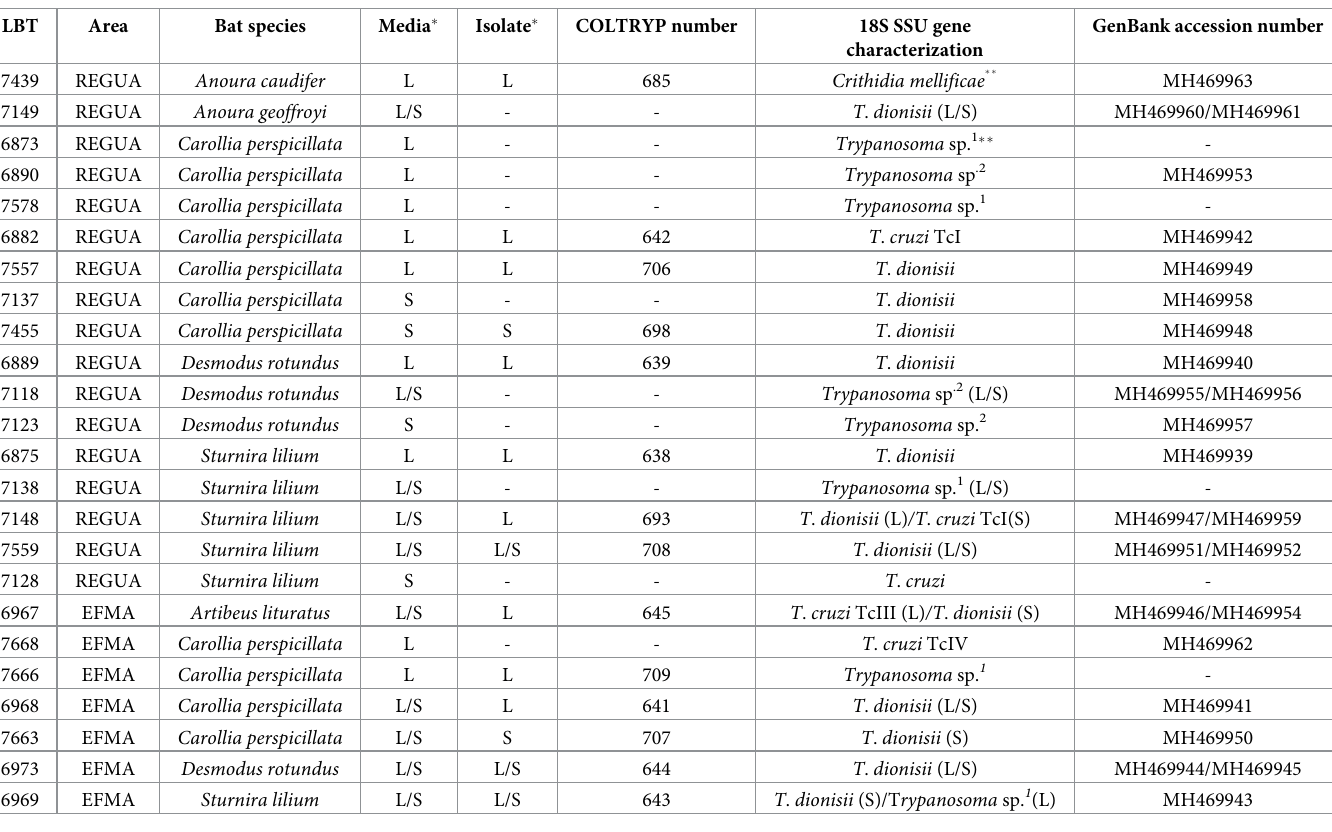
Table 2. Trypanosomatid species infecting bats. This table shows the bat identification number, area (Reserva Biolo´gica de Guapiac¸u/REGUA or Estac¸ ã o Biolo´gica Fio- cruz da Mata Atlaˆntica/EFMA), bat species, positive culture media, culture media in which the parasite was isolated and cryopreserved at COLTRYP (with their respective numbers) and the characterized parasite species and GenBank accession